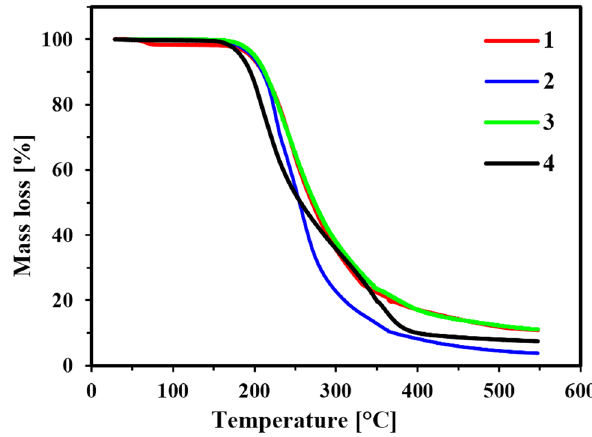
Figure 4: Thermal stability of the obtained salts ( 1 – 4 )